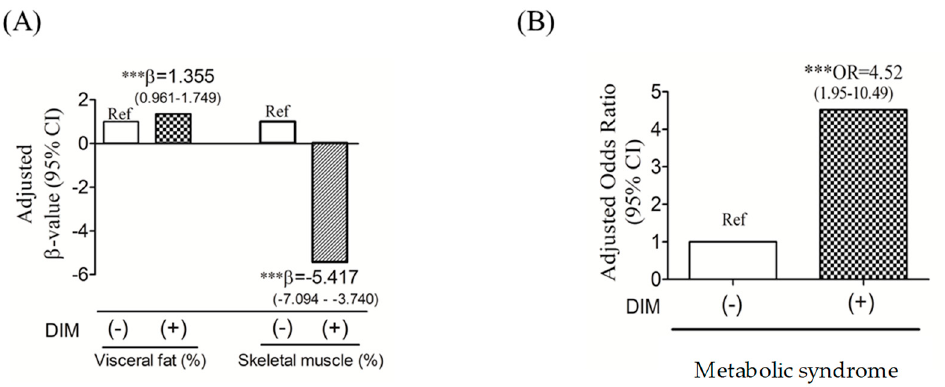
Figure 2. Adjusted multivariate linear and logistic regression and 95% confidence intervals of dysregulated iron metabolism (DIM) in terms of visceral fat mass (%) and skeletal muscle mass (%) ( A ) and metabolic syndrome ( B ). ( A ) the Beta coefficient ( β -value) was adjusted by age and sex, and ( B ) odds ratio (OR) was adjusted by age, sex, and body-mass index (BMI) ( N = 208). *** p ≤ 0.001.